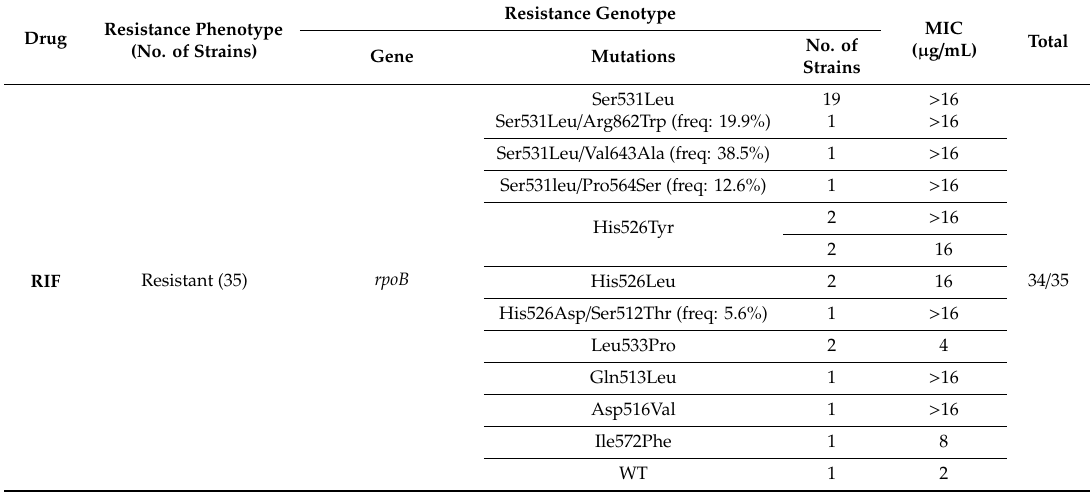
Table 2. Resistance-conferring mutations for the first-line anti-tuberculosis (anti-TB) drugs in 35 rifampicin-resistant Mycobacterium tuberculosis strains [3,26–29]. Drug Resistance Phenotype (No. of